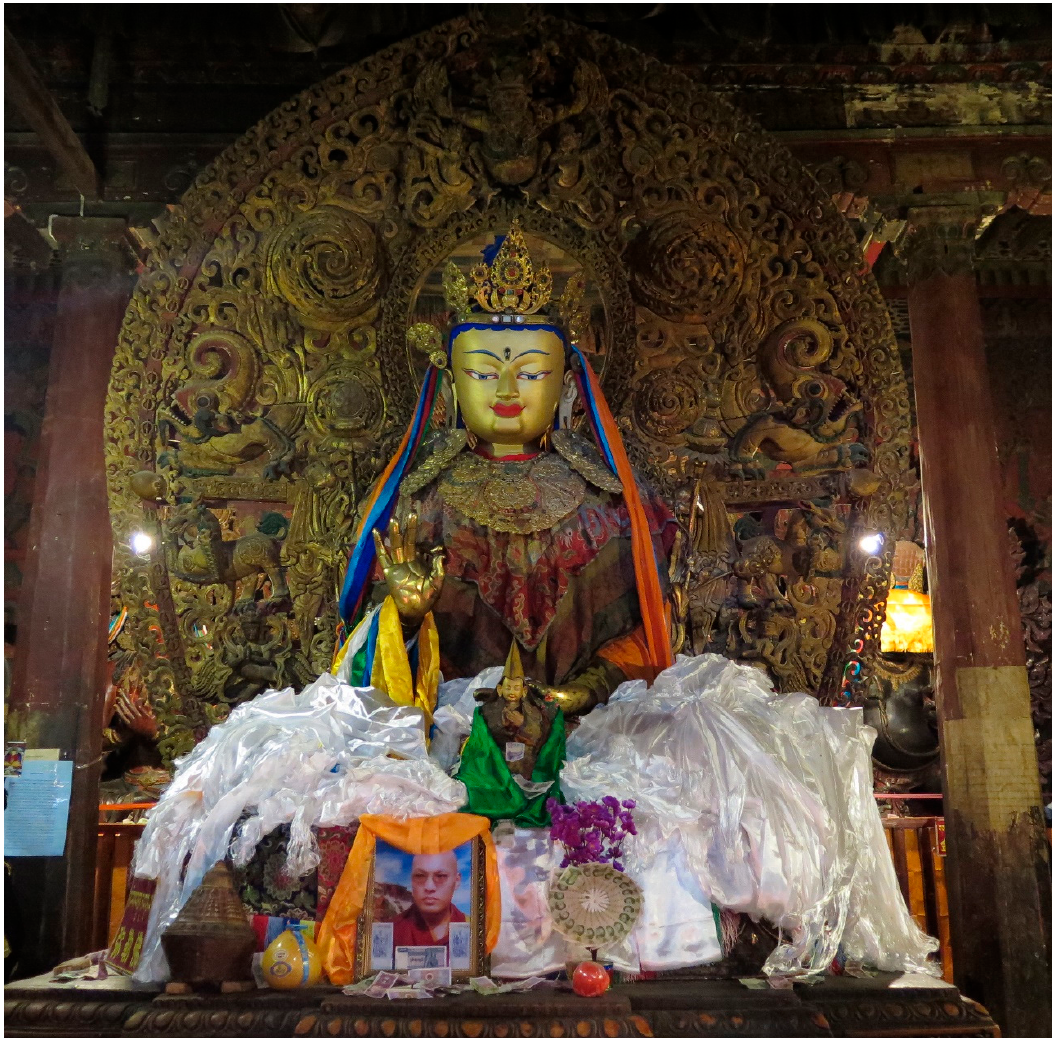
Figure 1. Silk scarfs and offerings to the statue of Maitreya, Gyantse Tsuklakhang, Tibet (photo C. Bellini 2016).